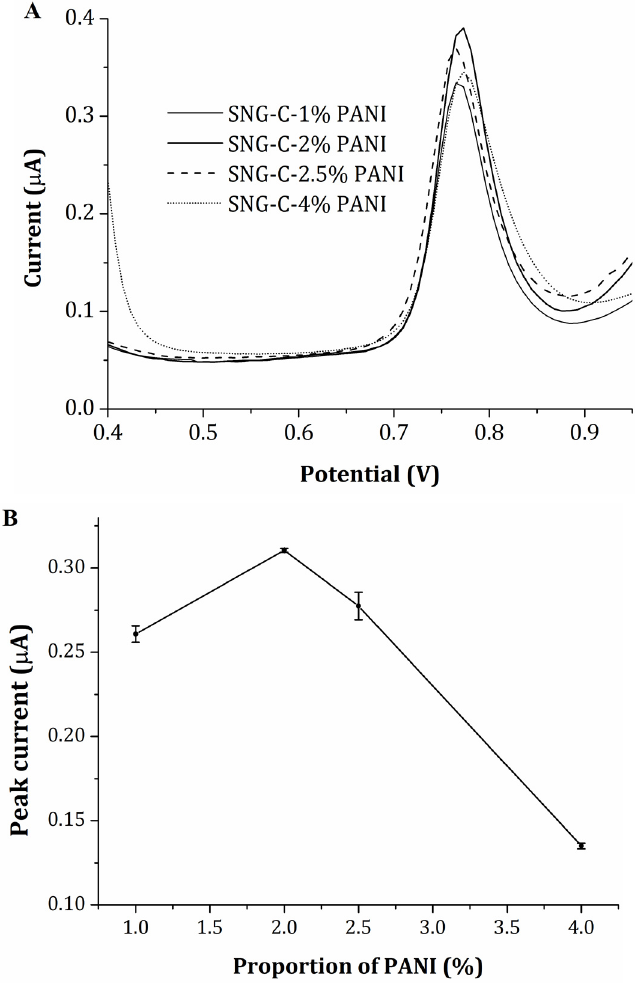
Figure 1. ( A ) Differential pulse voltammograms recorded with formulations with different proportions of polyaniline ranging from 1% to 4%, in presence of a 10 µ M 4-chloro-3-methylphenol solution. ( B ) Peak heights recorded using different proportions of polyaniline in a 10 µ M 4-chloro-3-methylphenol solution. A buffer solution containing 0.1 M acetic/acetate at pH 4 with 0.5 M KCl was used as electrolytic medium.